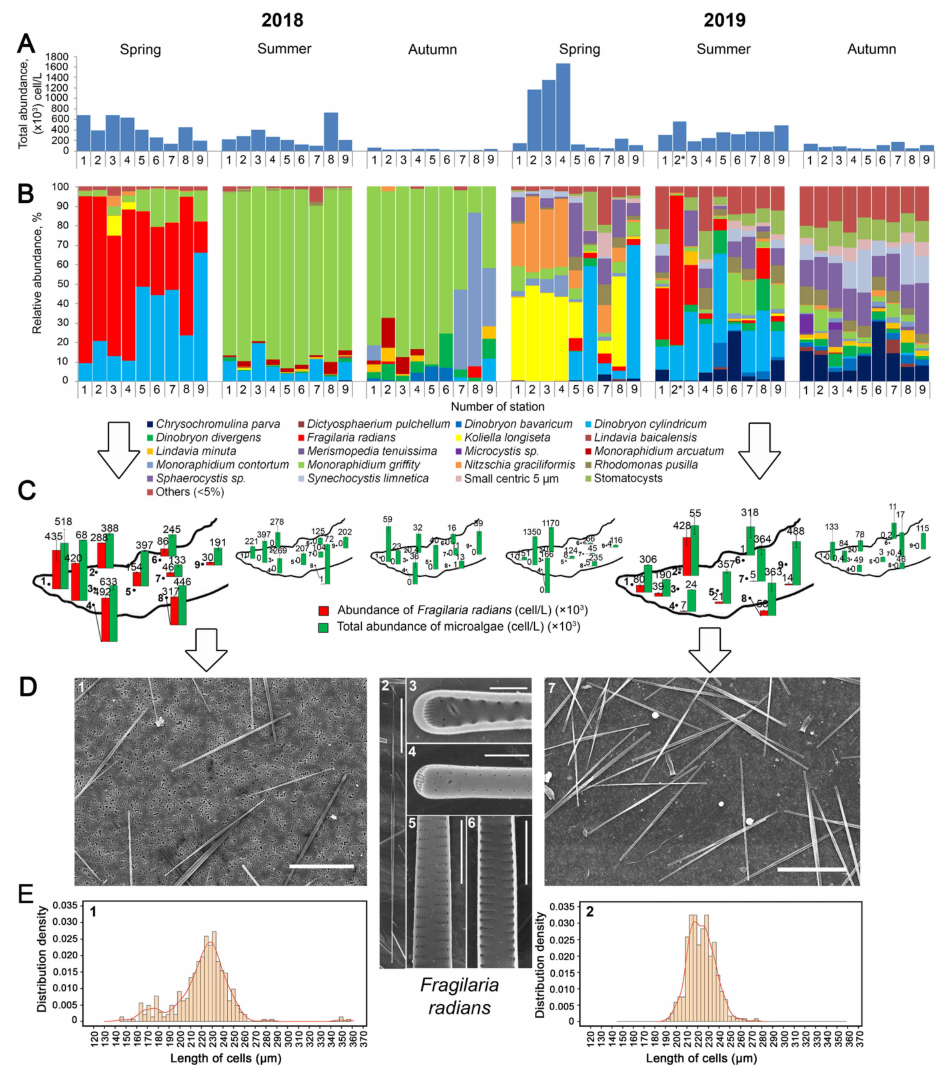
Figure 2. Fragilaria radians in phytoplankton of Southern Baikal in 2018–2019. ( A ) Total abundance of species in seasonal dynamics; ( B ) relative abundance of different species of microalgae in seasonal dynamics; ( C ) F. radians (red) compared with the total abundance of microalgae (green); ( D ) scanning electron microscopy of F. radians in May 2018 (1), July 2019 (7), and fine valve structure of the species (2: a valve; 3: an apex, inside view; 4: an apex, outside view; 5: striae, outside view; 6: striae, inside view); ( E ) cell length distribution in May 2018 (1) and July 2019 (2). (A–C): for station numbers, see Figure 1 and Supplementary Table S1. Scale bars: D1—100 µ m; D2—50 µ m; D3 and D4—2 µ m; D5 and D6—5 µ m; D7—100 µ